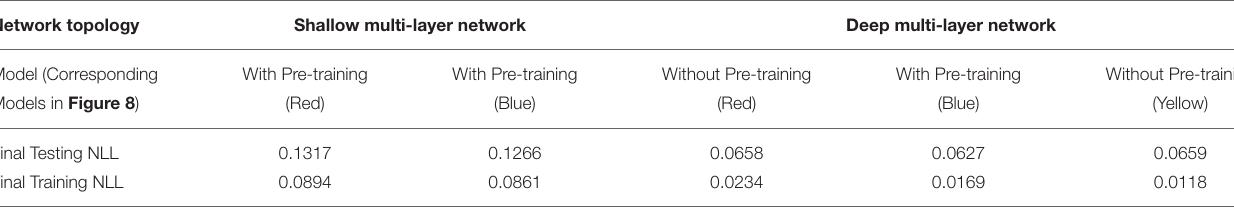
TABLE 5 | Final testing and training NLL costs (averaged out over 130–150 epochs) in shallow and deep multi-layer networks. Network